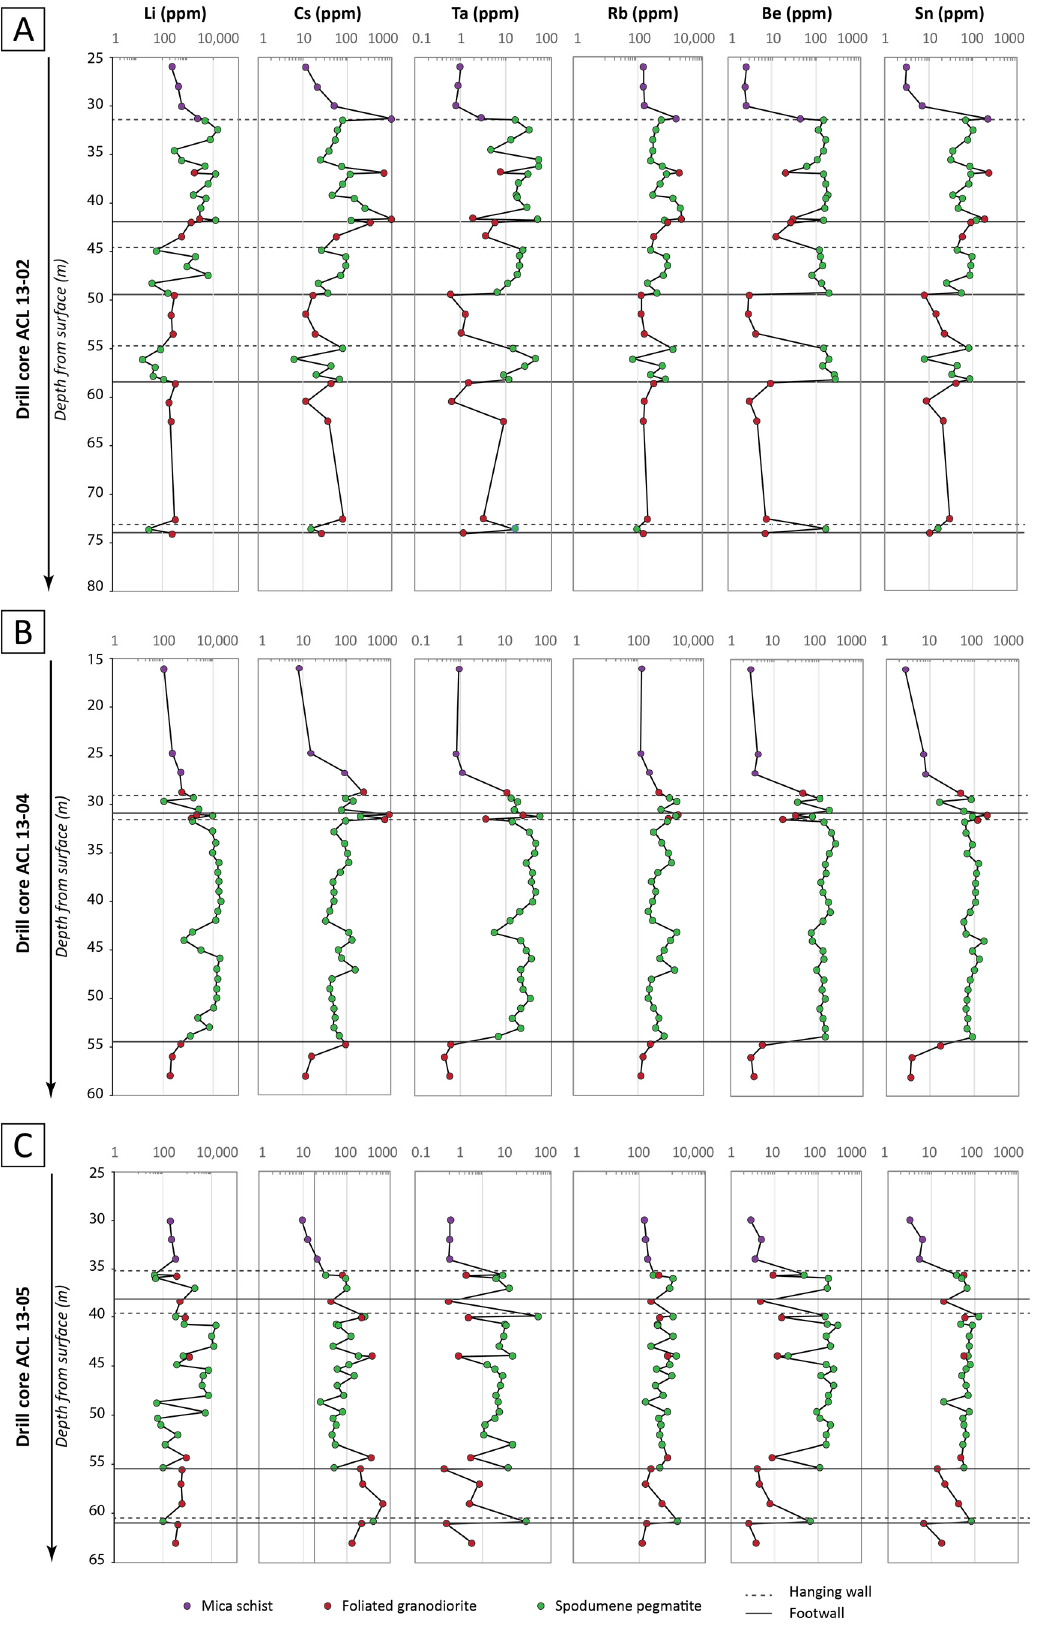
Figure 8. Geochemical profiles for Aclare drill cores ( A ) ACL 13-02, ( B ) ACL 13-04 and ( C ) ACL 13-05. A 30-cm-wide spodumene pegmatite intrusion is omitted in ( B ). Drill holes intercepted pegmatites at ~90°.